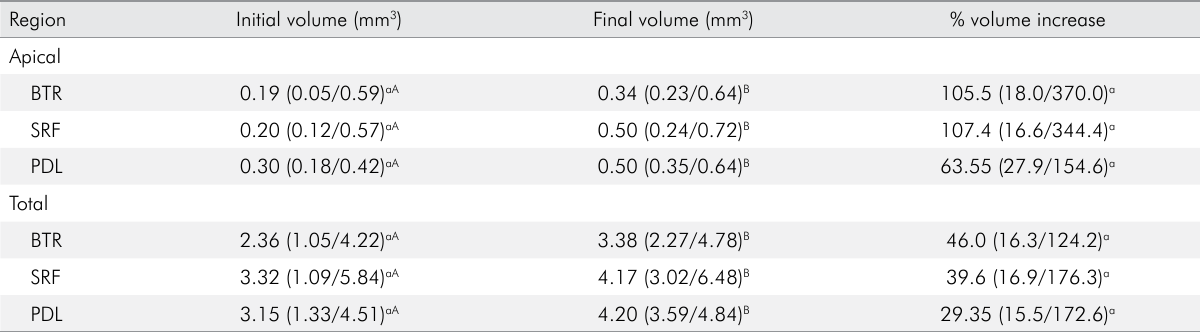
Table 1. Median, minimum and maximum values for volume, in mm 3 , and percent volume increase after the use of different rotary systems.